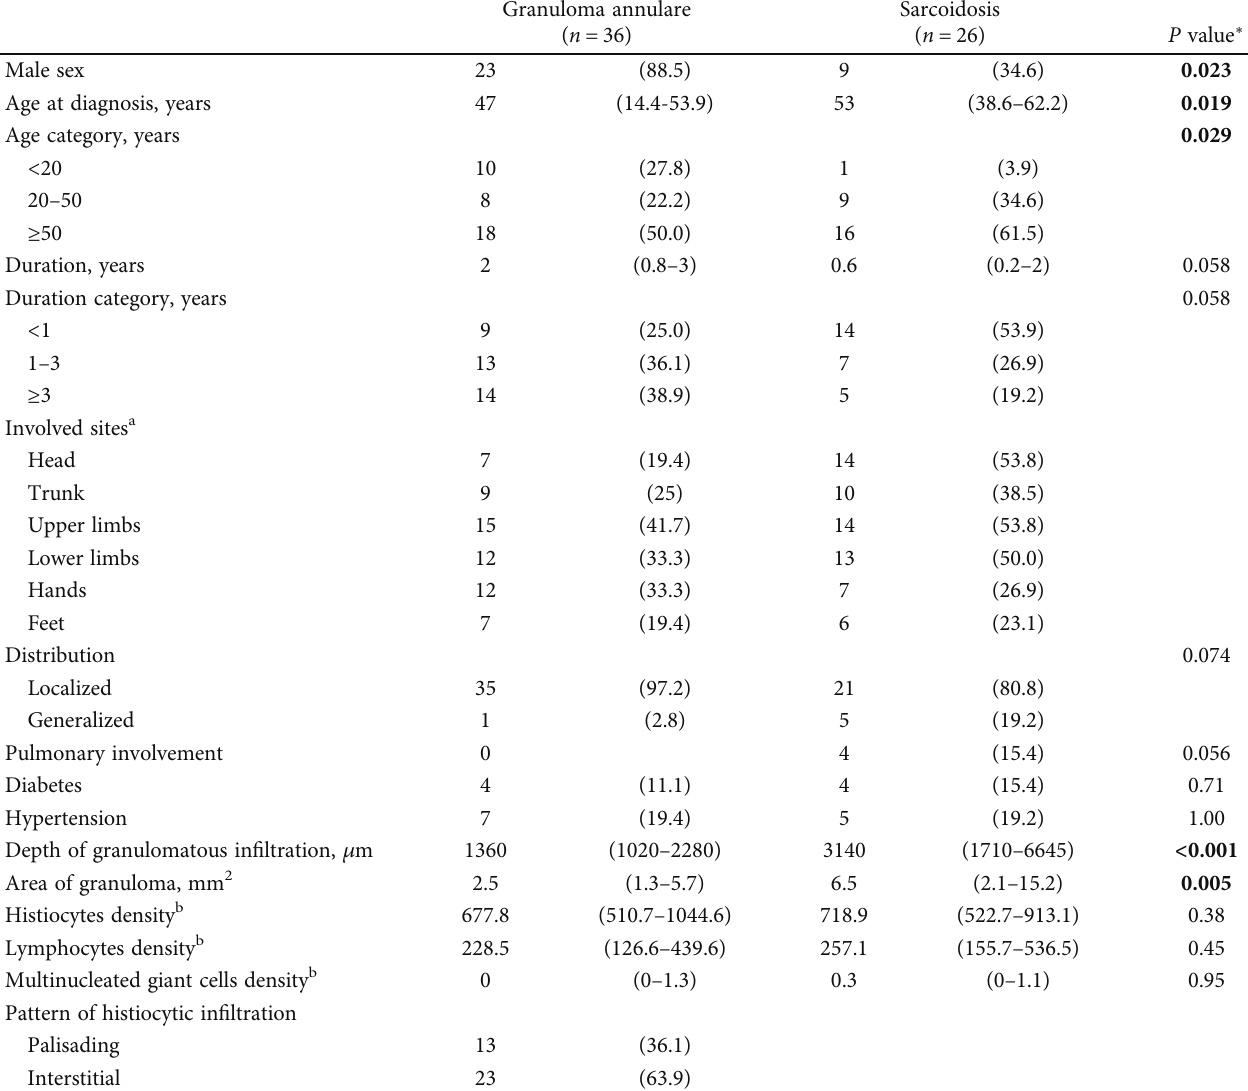
Table 1: Comparison of clinical and histological characteristics of patients with GA and